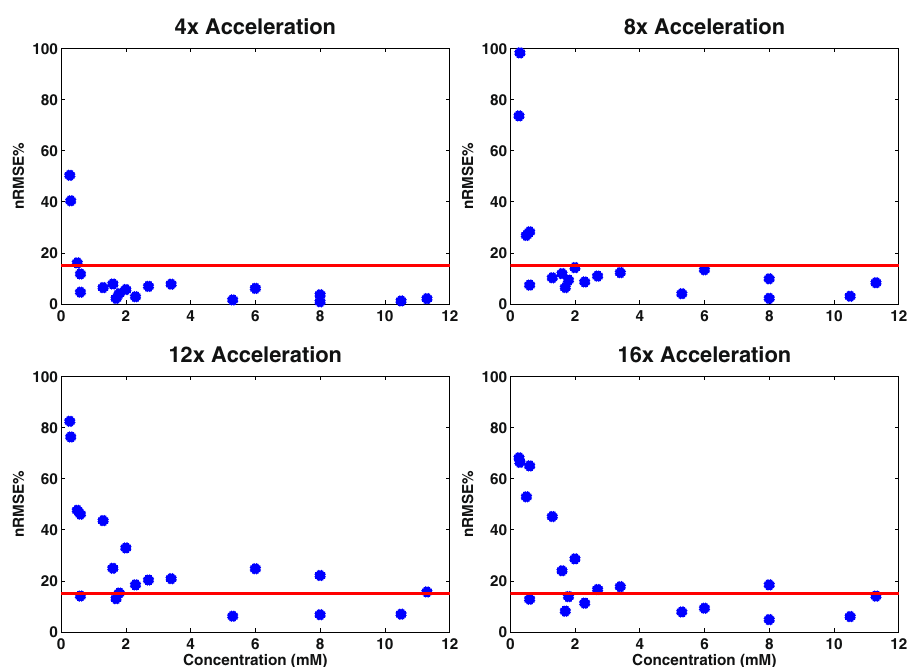
Figure 4. Concentration values for the simulated metabolites are plotted against nRMSE% values in blue. The red line is indicative of nRMSE% = 15%, which is the cutoff for acceptable quality used in this study. From the plots, it is apparent that nRMSE% increases as the metabolite concentration decreases. Furthermore, nRMSE% increases as the acceleration factor increases in